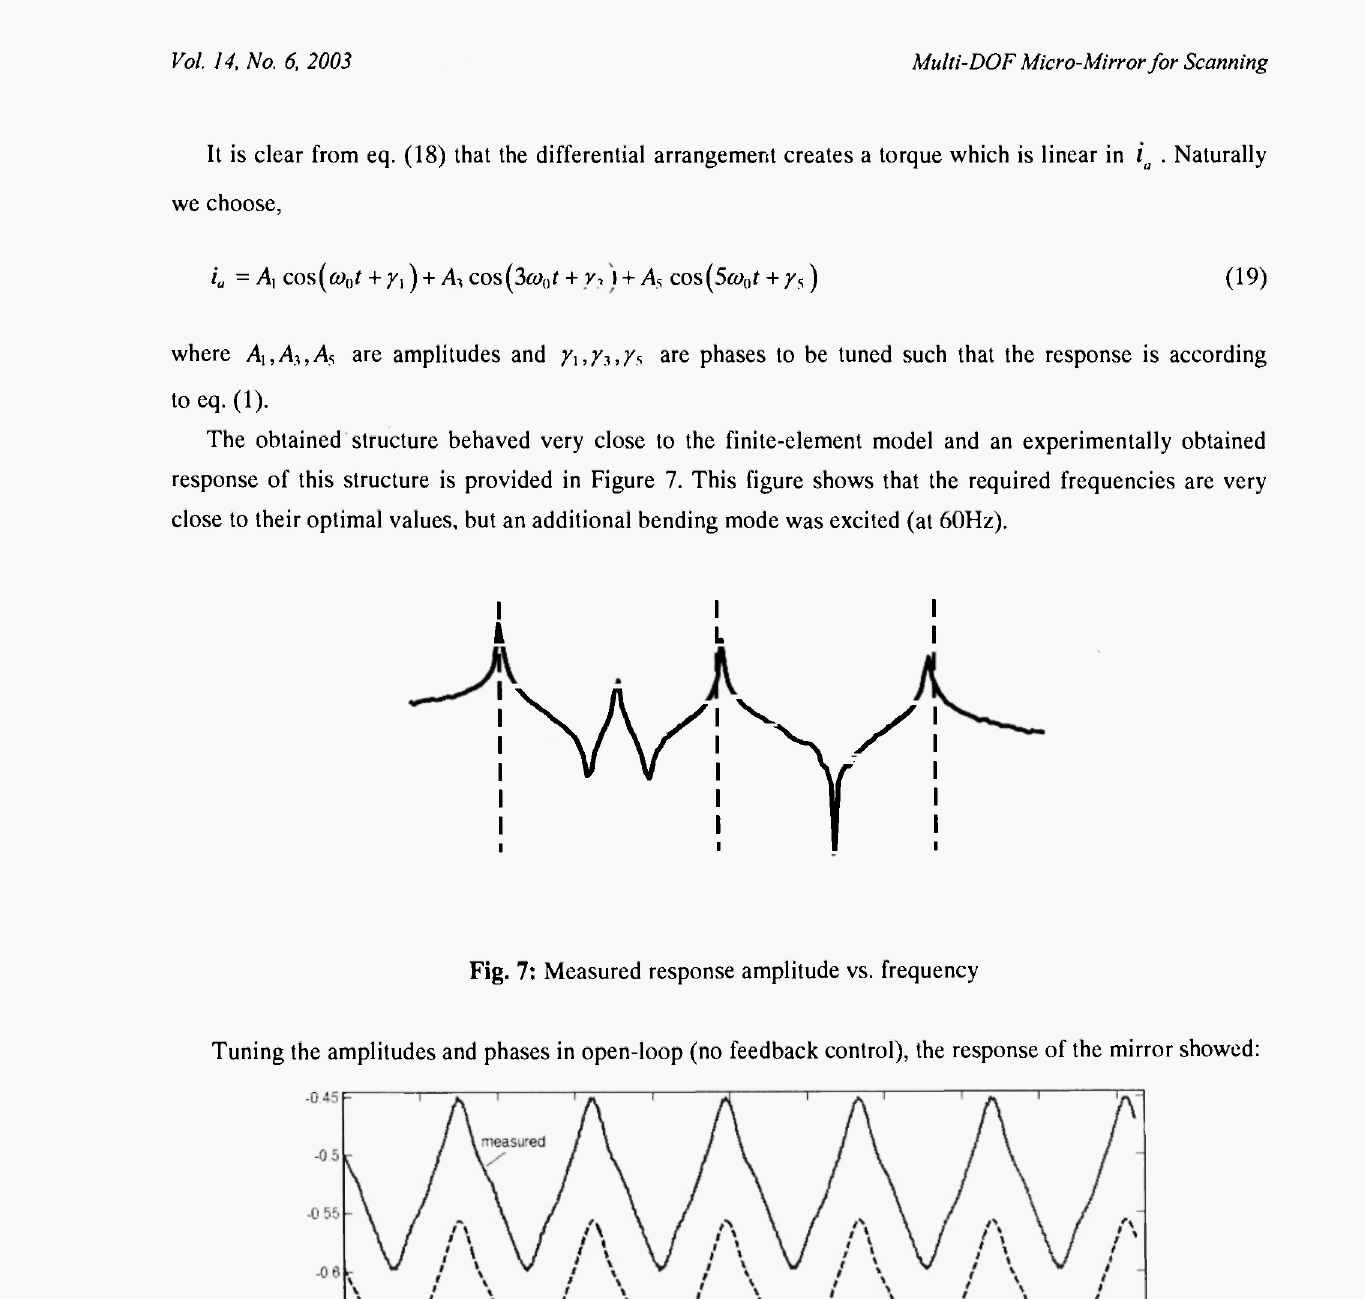
Fig. 8: Measured time response (top) and fitted 3 terms of the Fourier